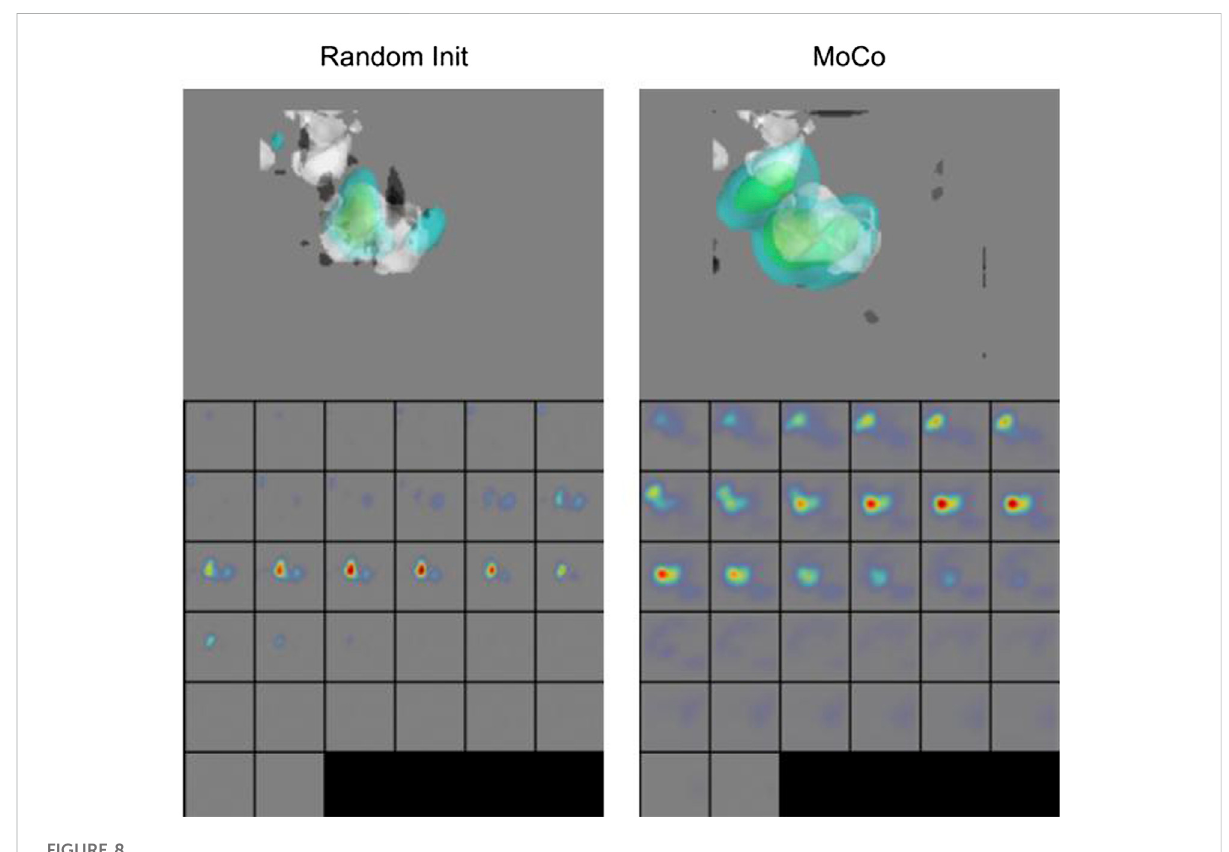
FIGURE 8 Grad-CAM Visualizations. CSSL (MoCo) pretrained model shows wider regions of 3D space, indicating regularization effect of CSSL pretraining (Newell and Deng,